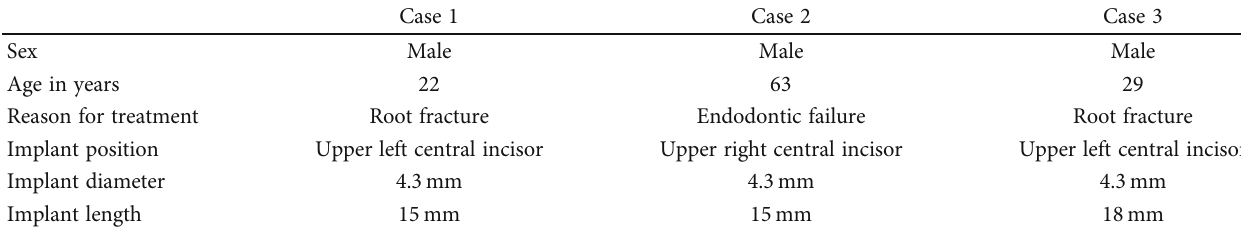
Table 1: Patient information.